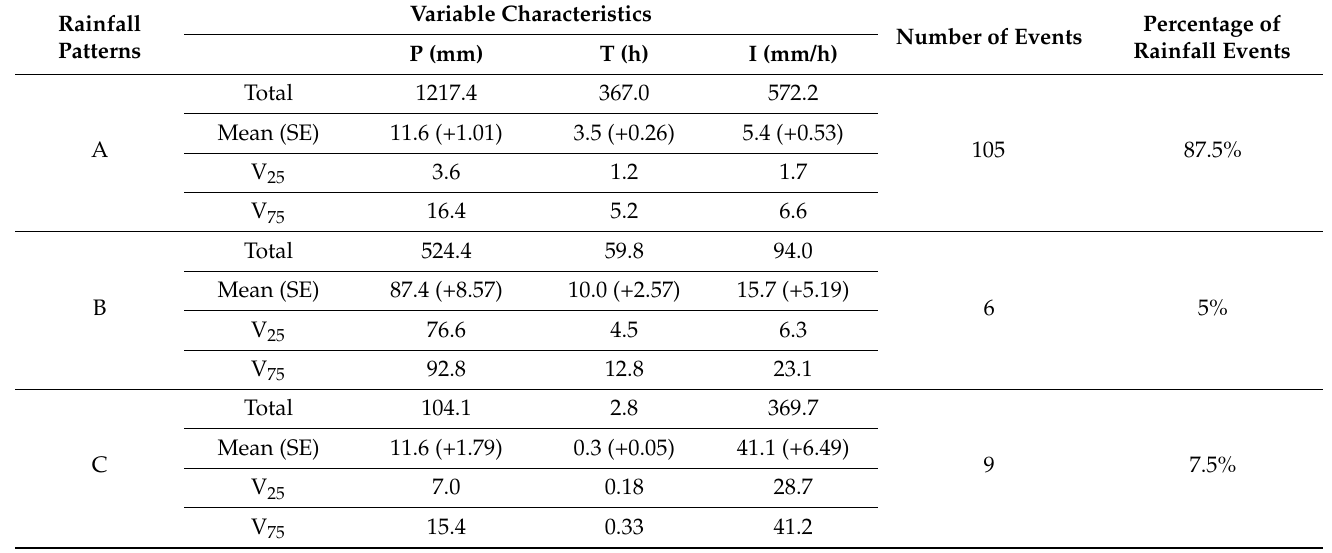
Table 2. Characteristics of different rainfall